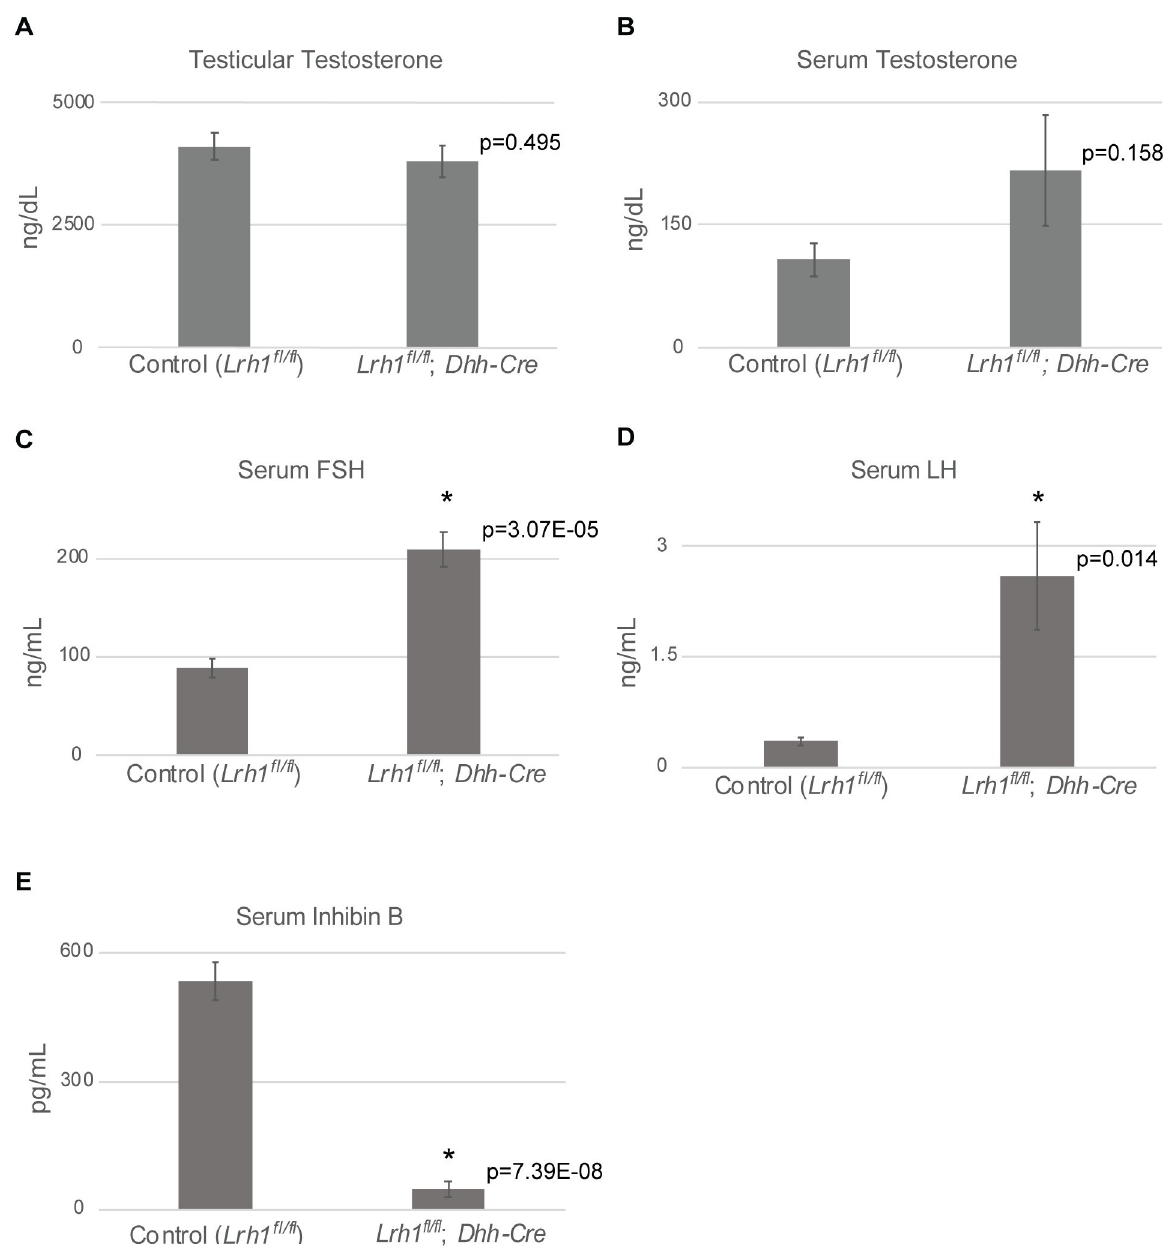
Fig 10. Lrh1 is required in Sertoli cells for feedback regulation of the hypothalamic-pituitary axis. Plots show mean and standard deviation for hormone levels in control (N = 12) and Dhh-Cre conditional Lrh1 mutant (N = 10) testes (A) or serum (B-E). Asterisks indicate statistically significant difference. Error bars: